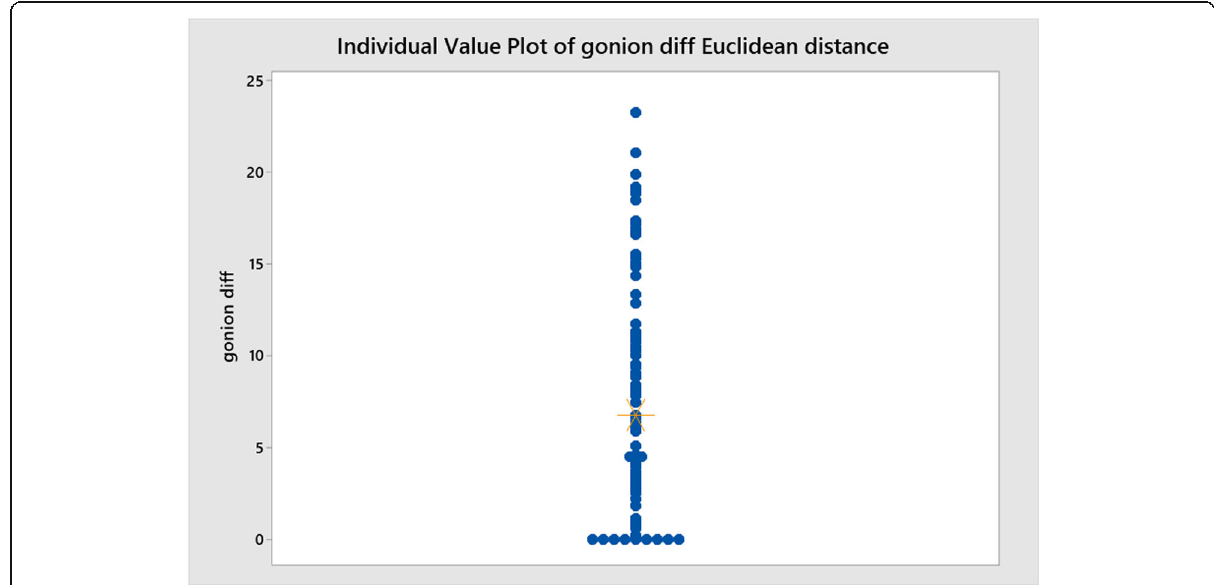
Fig. 6 Individual value plot showing mean distances between traced position of Go and estimated position by Sassouni+ analysis